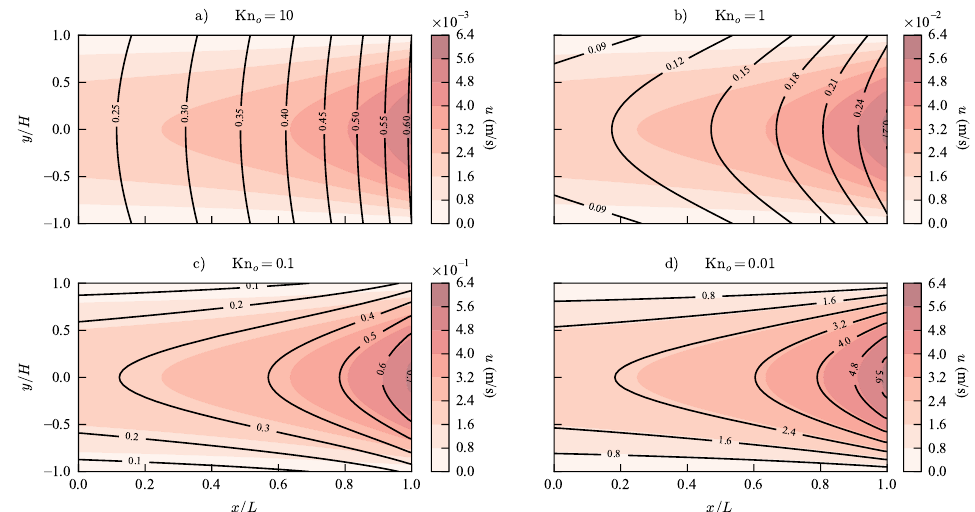
Figure 6. (Color Online) Stream-wise velocity contours predicted by the new model for outlet pressure conditions corresponding to Knudsen numbers ( a ) 10, ( b ) 1, ( c ) 0.1 and ( d ) 0.01. The velocity contour lines are plotted over the stream-wise velocity contour field for a typical parabolic velocity profile predicted by N-S equations with no slip boundary